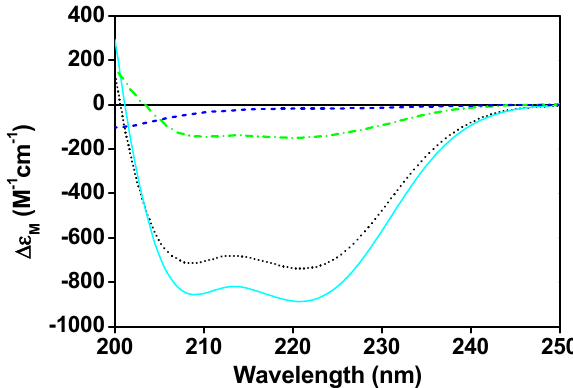
Figure 1. The secondary structure of CaM/CaNp complex. Far-UV CD spectra of CaM (black dotted line), free CaNp (blue dashed line), the complex of CaM and CaNp in a 1:1 molar ratio (cyan solid line), and the difference between the CaM/CaNp complex and free CaM (green dashed/dotted line). The CD spectra were taken at the concentration of 10 µM CaM and/or 10 µM CaNp in 100 mM KCl, and 2 mM CaCl 2 at pH 6.5.